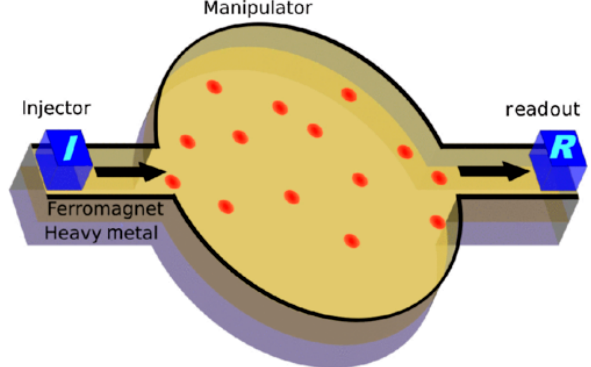
Figure 4. Generic skyrmion device consisting of a thin film ferromagnet/heavy metal bilayer, showing the manipulation of skyrmion between injection and readout. Reprinted with permission from [46]. Copyright (2018) by the American Physical Society.